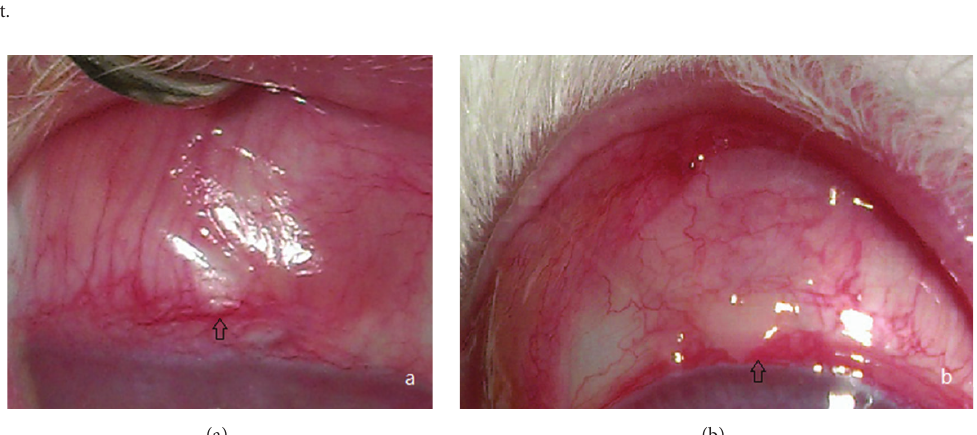
Figure 3: Exposure of implant happened in 2 eyes; both of them were repositioned by conjunctival suture and recovered well. (a) Exposure of Ologen in control group. (b) Exposure of P1 in Group 1.